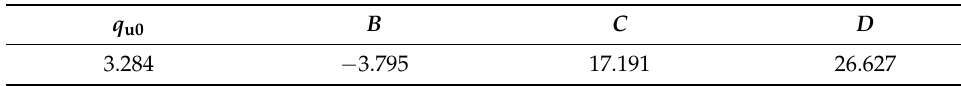
Figure 12. Relationship between shear stress and curing age ( D R = 30%). 3.3. The Effect of D R on Resistivity Figure 13 illustrates the relationship between resistivity of RMLS mixture and D R at the curing age of 28 d . It can be observed that resistivity of RMLS mixture showed the maximum value when D R = 0 (loessial silt) and decreases with the increase of D R . The descending process of resistivity can be divided into three stages: stage I (0% < D R < 24%), in which the resistivity decreases rapidly and D R has a significant effect on the resistivity change; (2) stage II (24% < D R < 42%), the decreasing trend slows down and effect D R is reduced; (3) stage III (42% < D R < 54%), the resistivity tends to be a constant value and D R has little influence on it. The w opt value of RMLS mixture increases as the D R increases, and pore moisture con- tent increases accordingly since volume of sample is fixed. In stage I, charged particles and clay particles dissolve in red mud because of its good hydrophilic capacity, which enhances the conductivity of RMLS mixture and reduces the resistivity significantly. As D R increases, stage II begins, in which the concentration of dissolved ions reduces and thus the decreasing rate of resistivity is less than stage I. In stage III, the concentration of dissolved ions remains at a constant value such that the decreasing trend of resistivity is gradually weakened and tends to be stable finally.